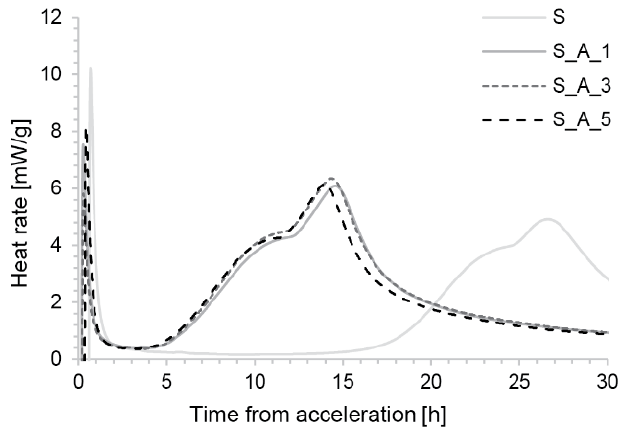
Figure 8. Hydration kinetics of the S mix accelerated with the combination of aluminium sulfate solution and a superplasticizer.